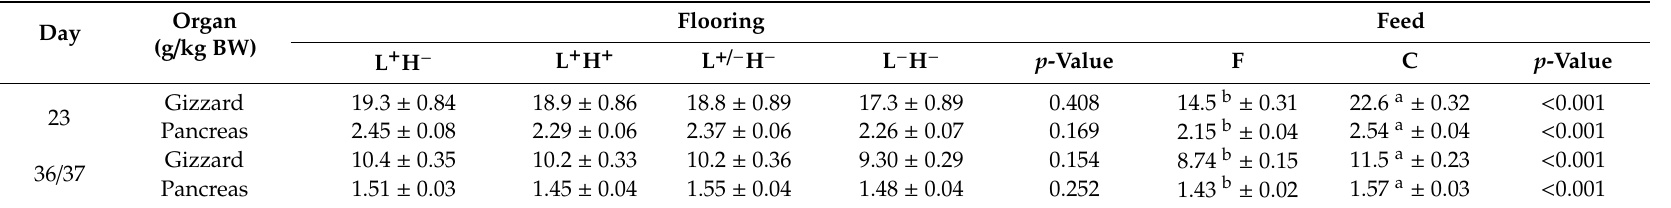
Table 5. Relative mass of the gizzard and pancreas (g / kg BW ± SEM) of broilers at dissection days (flooring,